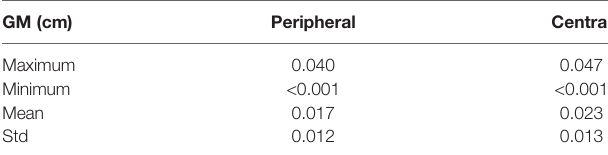
TABLE 4 | Absolute error of analytical and actual